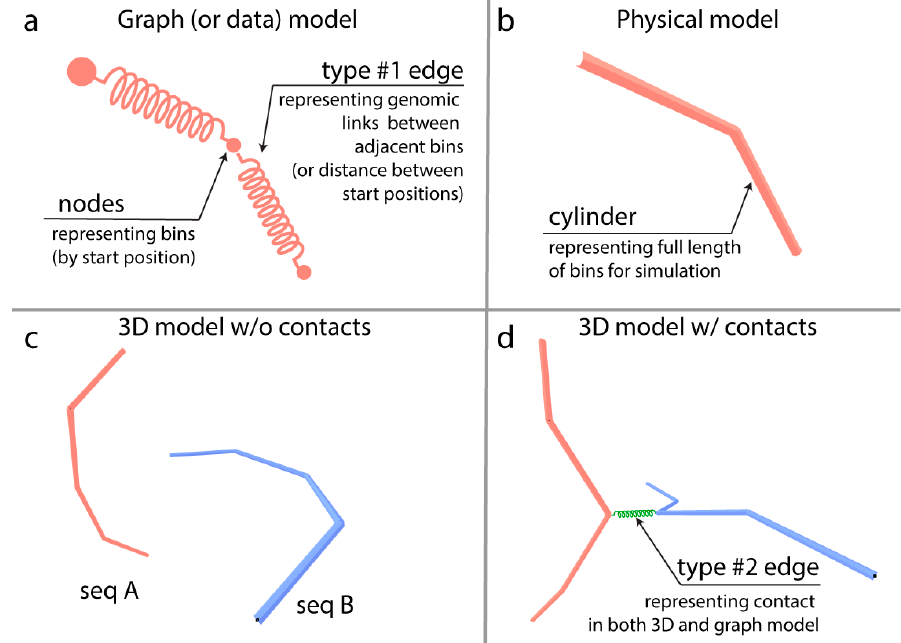
Figure 1. A visual summary of the multigraph model. ( a ) The graph/data model depicts the genome as a graph of adjacent bins. ( b ) The physical interpretation of the graph-based genome model is that nodes represent the start positions of the bins and edges are the physical representation of the bins which are visualized as cylinders. ( c ) Two dummy chromosomes (seq A and seq B) without contacts set in an energy-minimalizing configuration. By adjusting the properties of the bins, the cylinders can be shorter or longer which, in turn, can be used as a model for condensed or decondensed state. ( d ) Between nodes, a type #2 edge can be introduced based on contact data from Hi-C experiments. This puts extra strains on bins, therefore changing the configuration and length of cylinders (while its parameters are unchanged); hence, a graph-based 3D genome. Since the genome and the contact graphs are two different graphs of the same node set (called vertices in graph theory), our 3D genome model is a